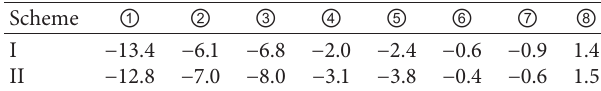
Table 2: Final displacement value of monitoring points in initial support of tunnel unit: mm.